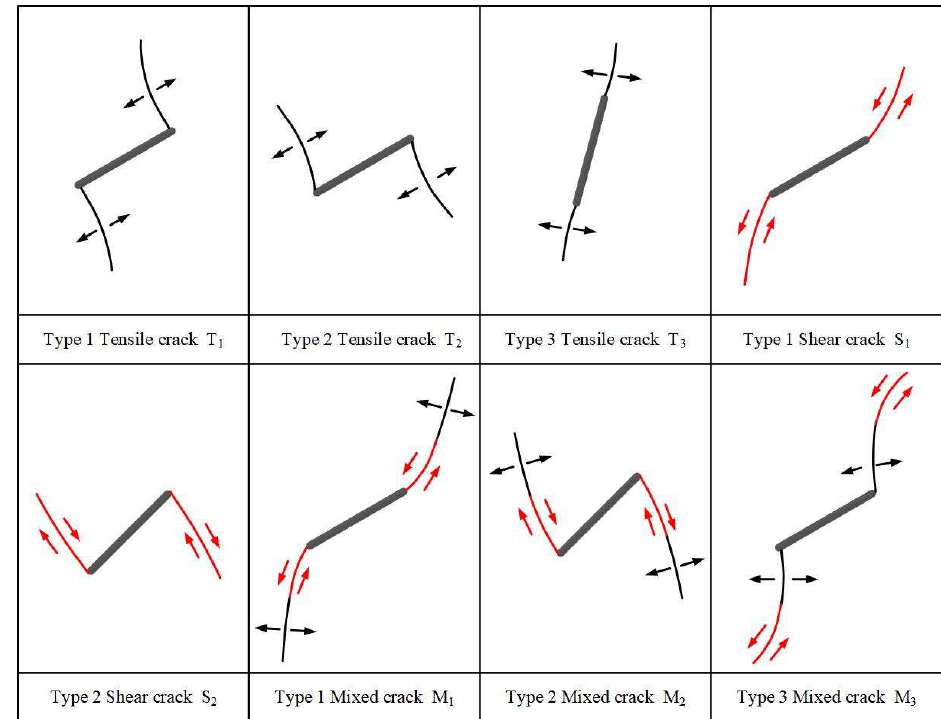
Figure 11. Crack types in this study (modified from reference